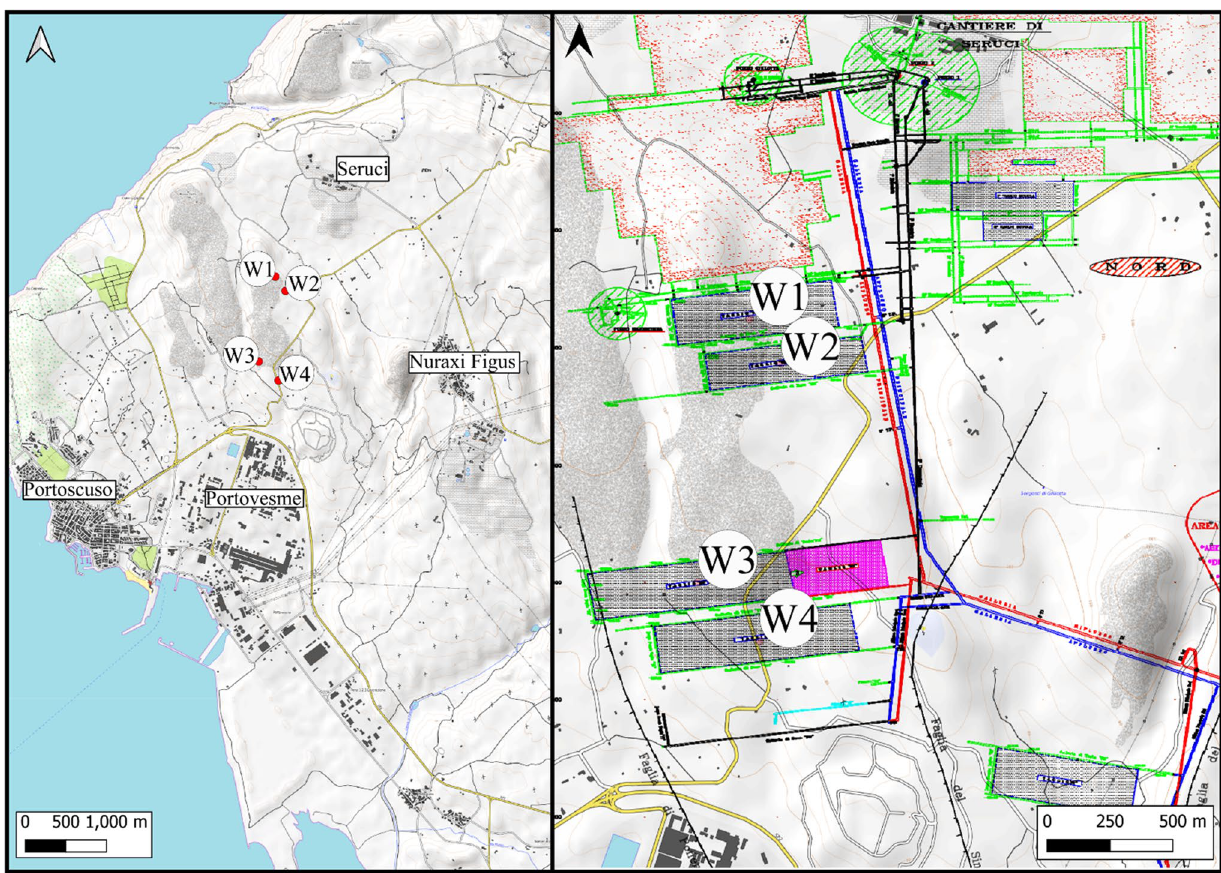
Fig. 2 Location of exploitation panels, W1, W2, W3, W4. On right the maps of underground tunnels and excavation